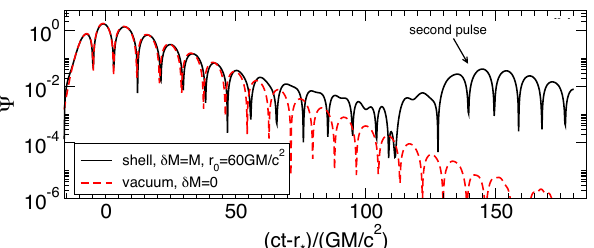
Figure 1. Axial waveform for a Gaussian pulse, scattered off a system comprised of a Schwarzschild BH and a thin shell located at r 0 = 60 GM/c 2 and with mass equal to the BH mass M . The Gaussian pulse is initially placed near the ISCO, with width σ = 4 GM/c 2 . Note that the signal is initially dominated by the isolated BH QNMs, with the effect of matter appearing as a second pulse at later times. Adapted from Ref.